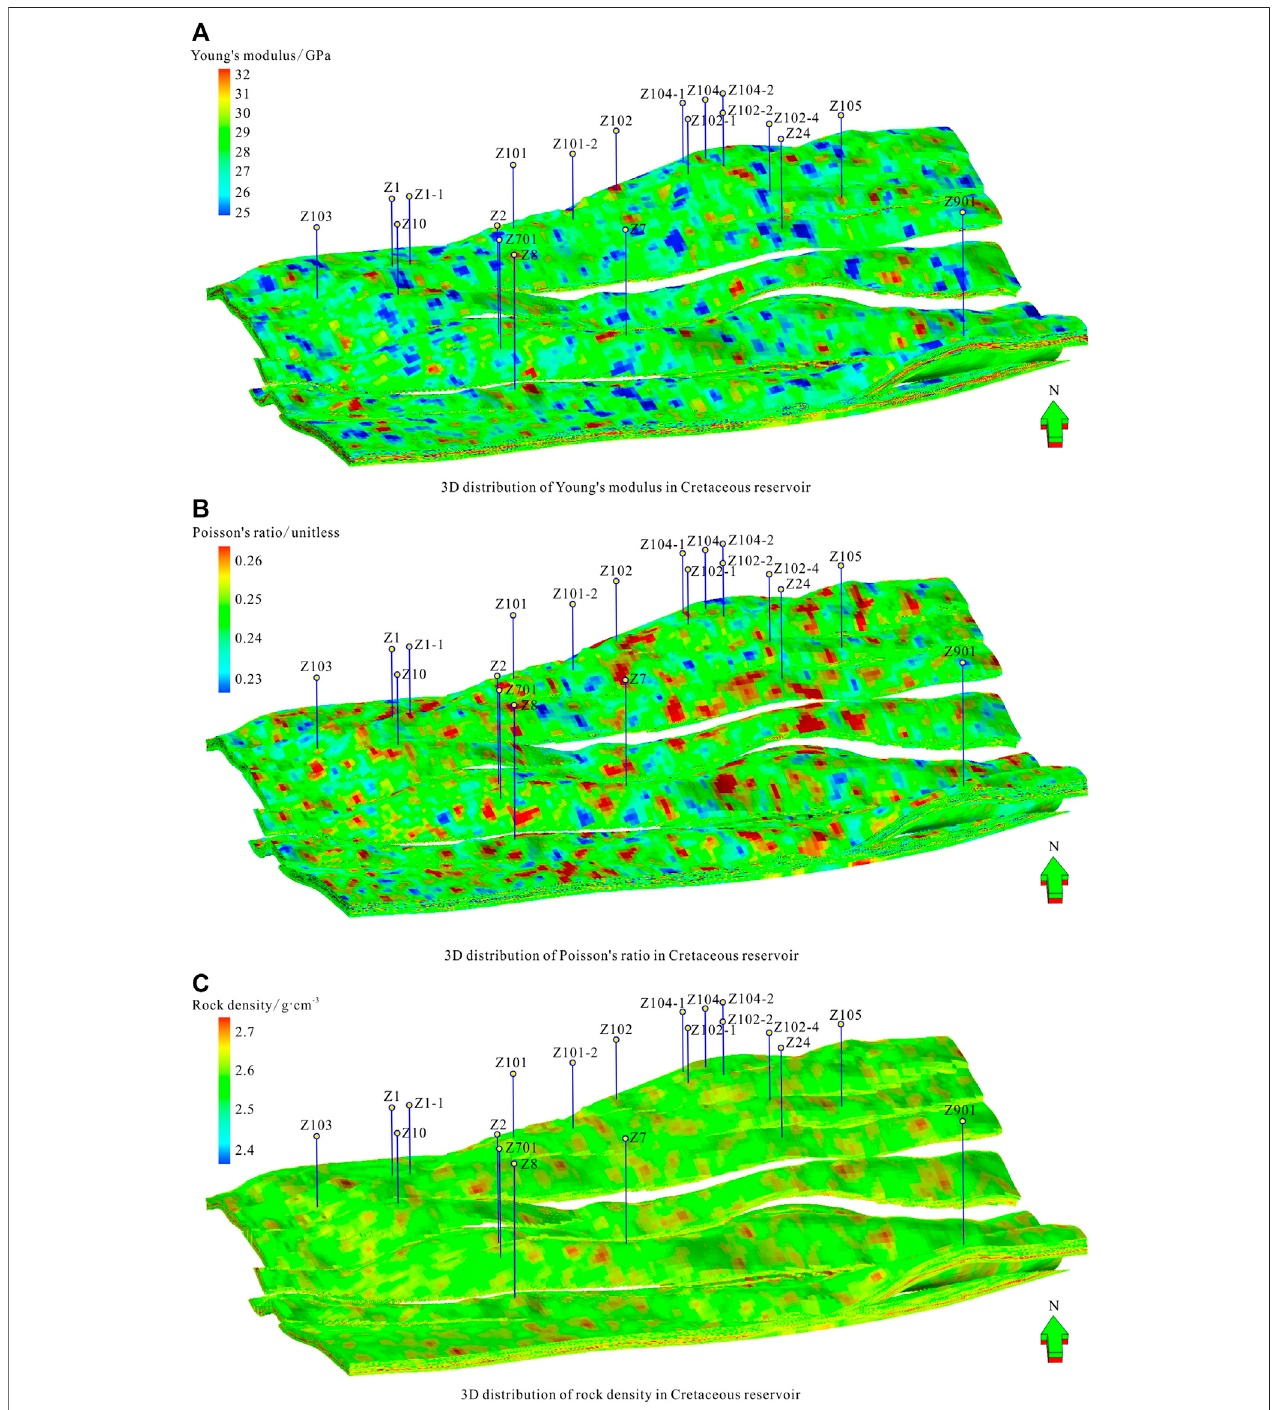
FIGURE9| 3DheterogeneousrockmechanicalparametersofBozigas fi eld, (A) 3DdistributionofYoung ’ smodulusinCretaceous reservoir; (B) 3Ddistribution of Poisson ’ s ratio in Cretaceous reservoir; (C) 3D distribution of rock density in Cretaceous reservoir.